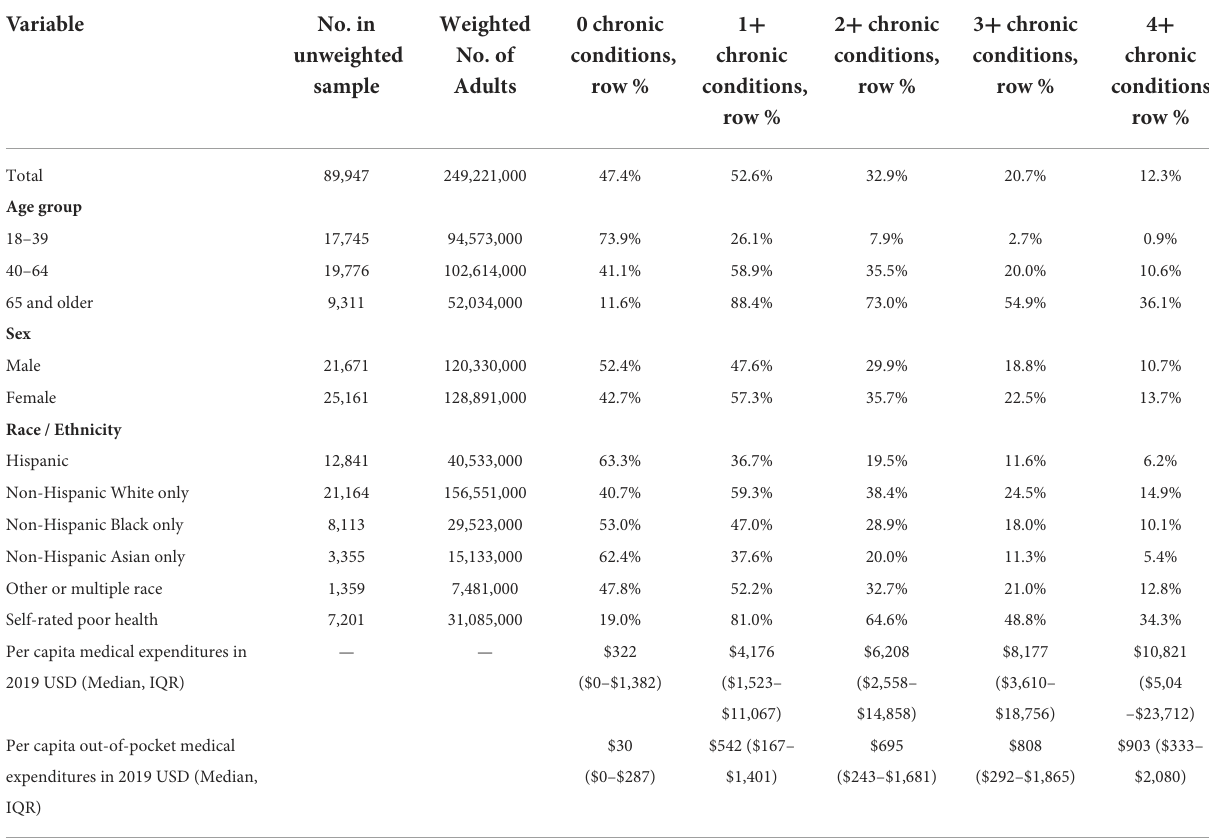
TABLE 1 Number of chronic conditions treated among U.S. adults by population characteristics. Variable No.